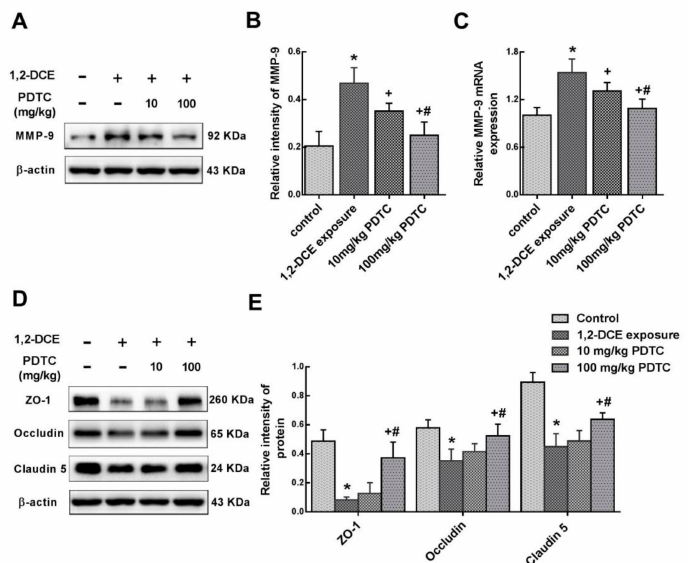
Figure 2. Involvement of NF- κ B in MMP-9 overexpression and TJs disruption in 1,2-DCE-intoxicated mice. ( A , D ) Representative images of Western blot analysis. ( B , E ) Graphs show the densitometric quantitation of MMP-9, ZO-1, occludin and claudin-5, which were normalized to the intensity of β -actin. ( C ) Measurement of mRNA levels by real-time RT-PCR. The mRNA levels of MMP-9 were normalized to GAPDH and presented as fold change of the control group. Data expressed as mean ± SD are the results of five independent experiments and analyzed by one-way ANOVA. Significant di ff erence is defined as p < 0.05, and *, vs. control group; + , vs. 1,2-DCE poisoned group; # vs. low dose intervention